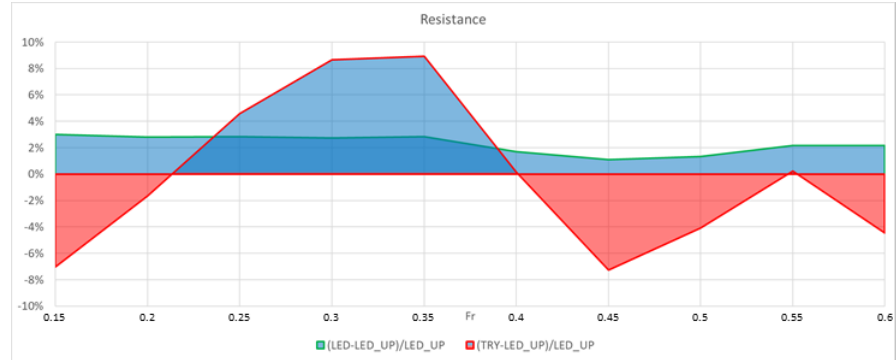
Figure 22. Difference in percentage between LED and LED_UP_06 and TryAgain and LED_UP_06.